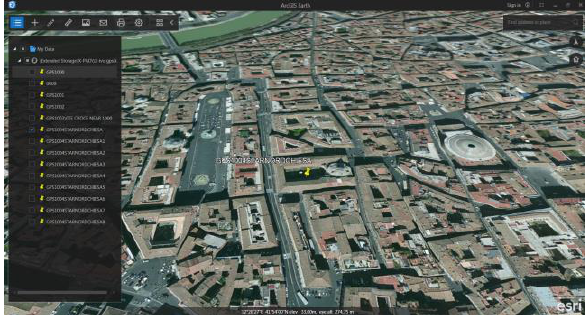
Figure 15. ArcGis Earth, geo-referenced KMZ survey